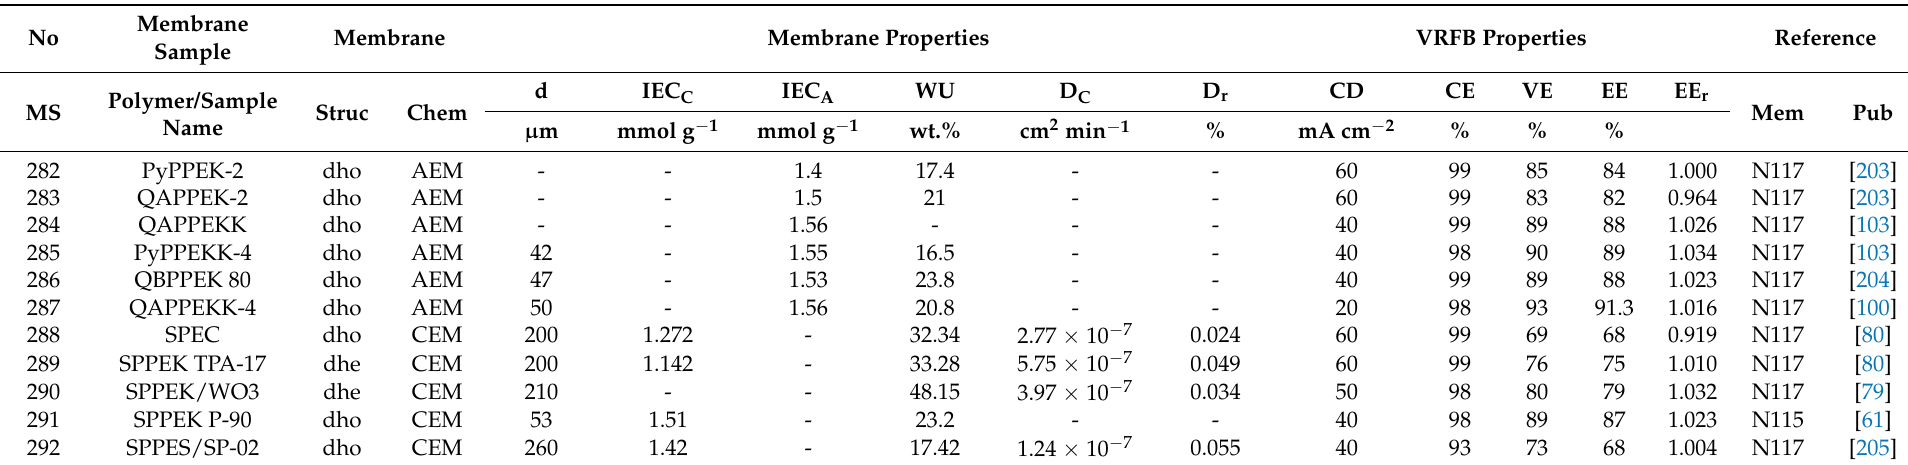
Table 13. List of poly(phthalazinone ether)-based N -heterocycle membrane samples.